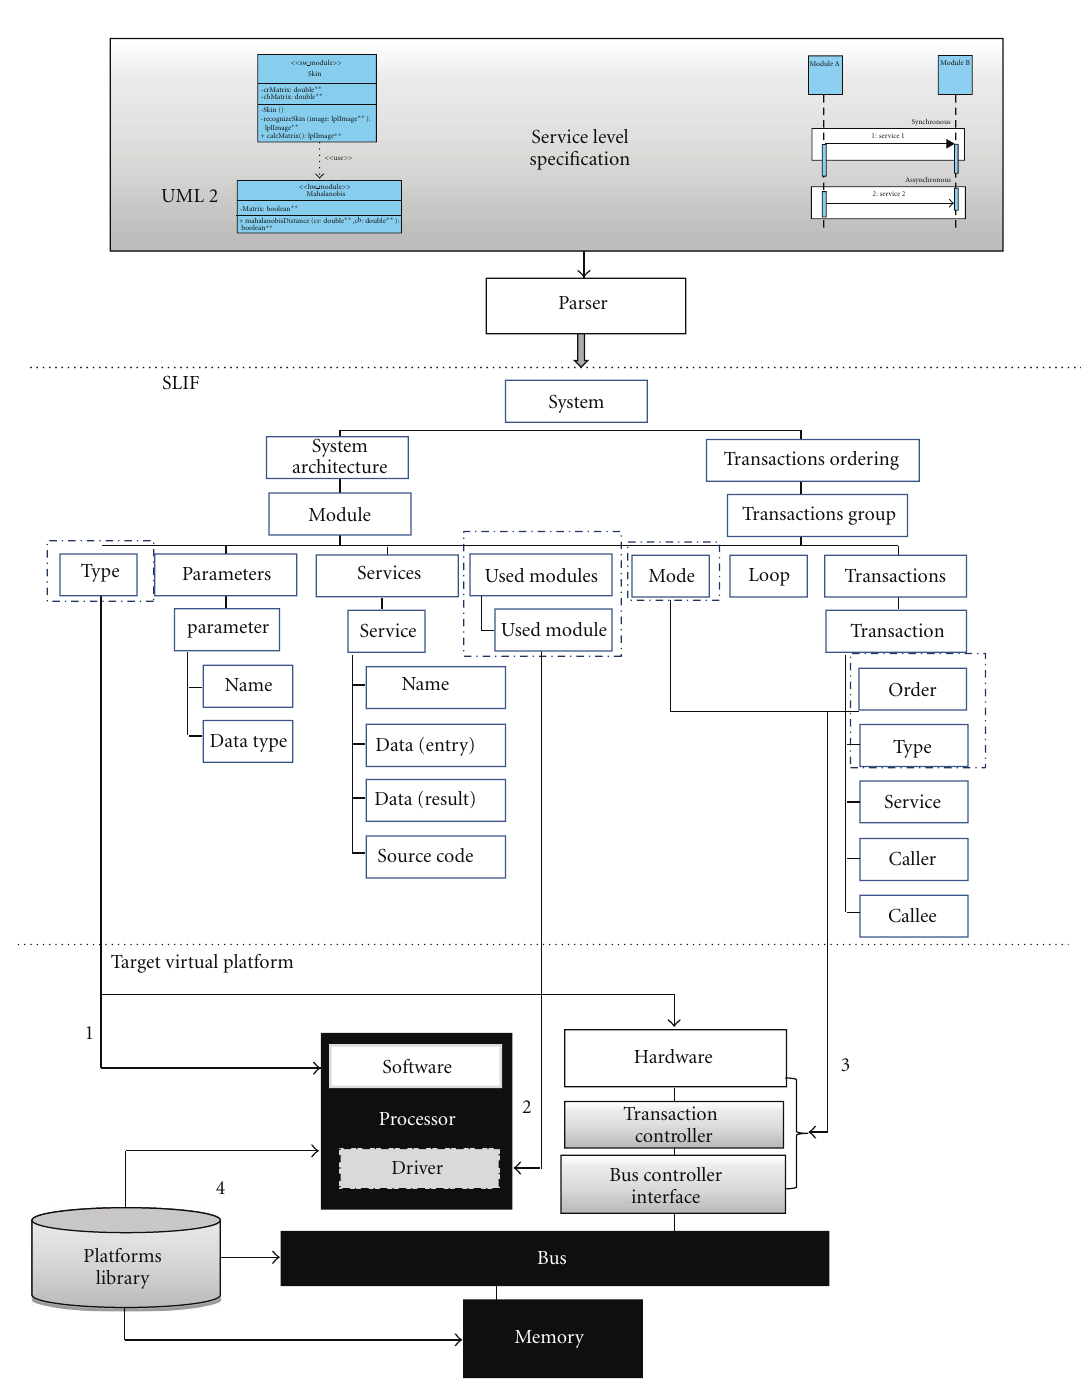
Figure 4: Service level system representation and target virtual